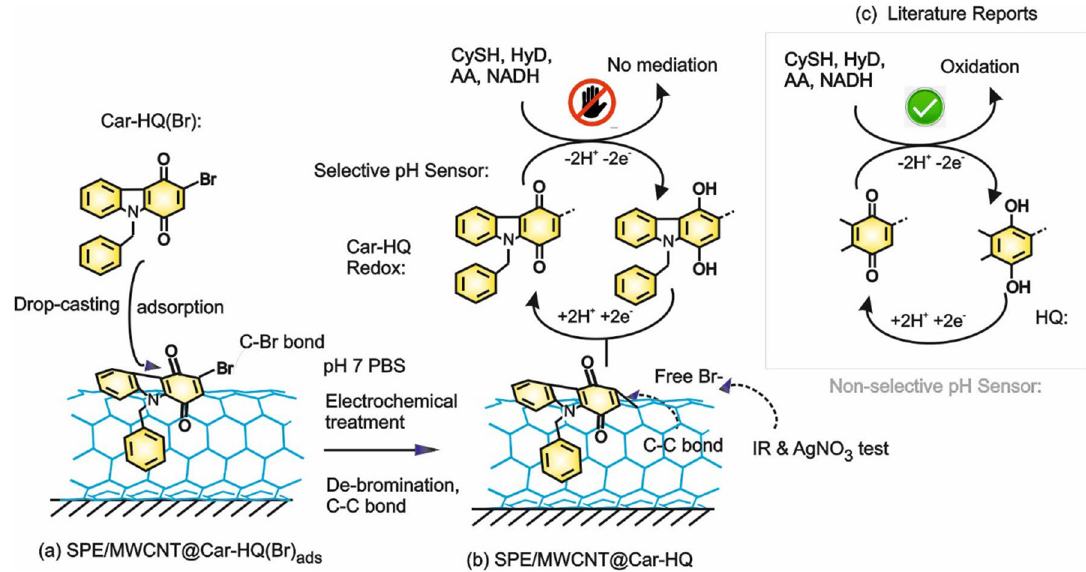
Figure 2. Illustration of preparation of Car-HQ immobilized MWCNT modified electrode by electrochemical approach ( a , b ) and its proton-coupled electron-transfer feature without any electrochemical/chemical/ electrocatalytic interference from various biochemicals unlike the conventional literature-based reports with hydroquinone and derivatives ( c tion of the redox-active organic molecule on the graphitic surface 28, 29 , and in turn to interference-free voltam- metric pH sensor application. By keeping all these points, a new redox-active organic compound, Car-HQ has been designed rationally and synthesized (Fig. 1 and Supporting info) for our electroanalytical studies (Fig. 2). Figure 3b curve-(i) is a ten continuous CV responses of Car-HQ adsorbed GCE in pH 7 PBS, showing a feature-less volumetric response. Interestingly, when the same experiment was performed on MWCNT modified GCE, GCE/MWCNT, a well-defined redox peak at an apparent standard electrode potential, E o ′ = − 0.160 ± 0.005 V versus Ag/AgCl with a peak-to-peak separation value, Δ E p = E pa – E pc , wherein, E pa and E pc are anodic and cathodic peak potentials, 50 mV (at v = 10 mV s −1 ; 150 mV at v = 50 mV s −1 ) and surface- excess, Γ = 47 n mol cm −2 were noticed (Fig. 3b and curve-(iii)). The calculated relative standard deviation (RSD) between the 1st and 10th cycles of the CV is 2.1% highlighting a stale voltammetric response of the organic molecular modified electrode. The effect of scan rate on the modified electrode showed a systematic increase in the anodic ( i pa ) and cathodic ( i pc ) peak current signals with an increase in the scan rate (Fig. 4a). Note that a shoulder-like observation is noticed at about 0.2 V versus Ag/AgCl which may be due to the electron-transfer feature of nitrogen functional group Car-HQ. A plot of i pa and i pc versus scan rate is linear ascribing adsorption- controlled reaction mechanism for the electron-transfer reaction (Fig. 4b). The kinetics parameters such as transfer coefficient, α and heterogenous electron-transfer rate constane, k s were calculated using following Laviron model equations for the surface-confined redox process system with Δ E p > 200 mV (Fig. 4c) 30, 31 .